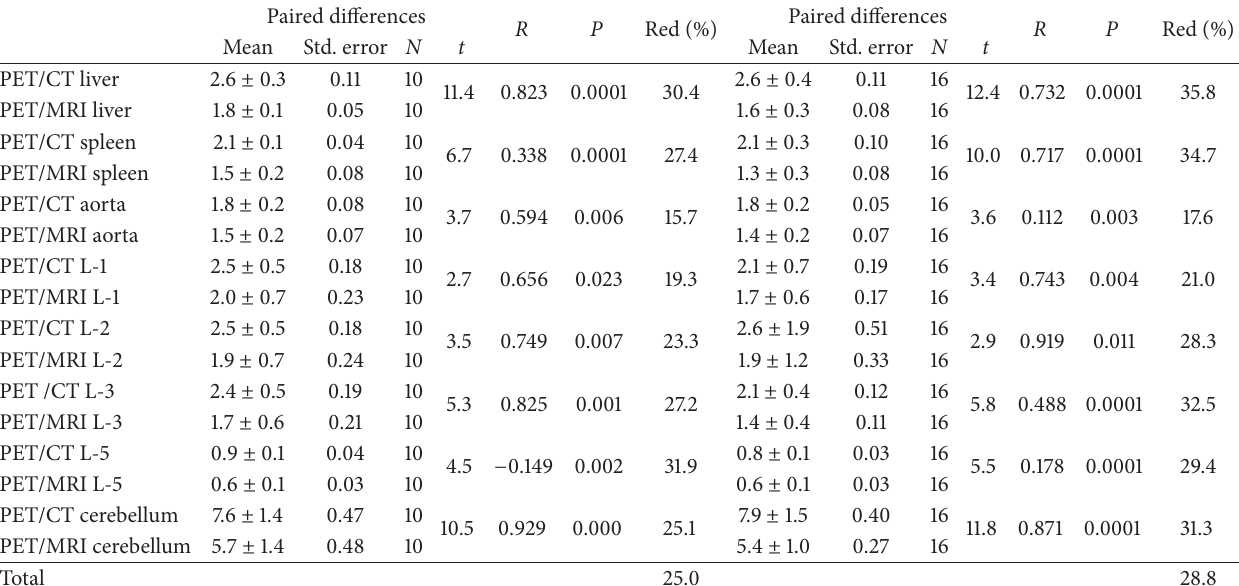
Table 7: According to noncontrast media or contrast media used, SUV -maximum normal volumes corresponding to PET/CT and PET/ LBM MRI. Paired differences Paired differences R P Red (%) R P Red (%) Mean Std. error N t Mean Std. error N t PET/CT liver 2.0 ± 0.3 PET/CT spleen PET/CT aorta PET/CT L-1 PET/CT L-2 PET/CT L-3 1.8 ± 0.4 PET/CT L-5 0.7 ± 0.0 0.5 ± 0.1 PET/CT cerebellum Total Table 8: According to noncontrast media or contrast media used, SUV -maximum normal volumes corresponding to PET/CT and PET/ BW MRI. Paired differences Paired differences R P Red (%) R P Red (%) Mean Std. error N t Mean Std. error N t PET/CT